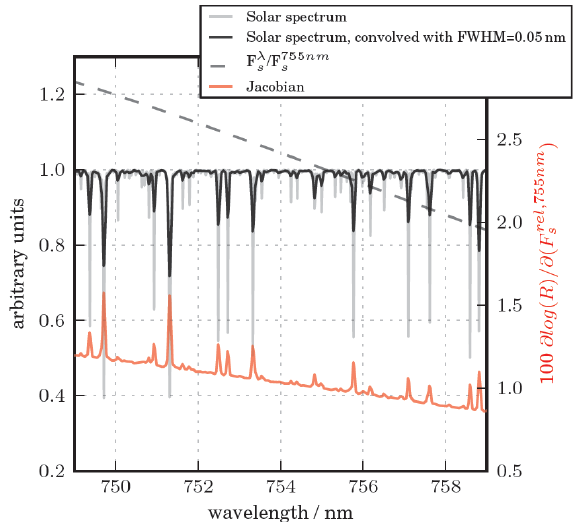
Fig. 14. Potential for fluorescence retrievals in the 749–759nm range with an imaginary instrument (spectral resolution of 0.05nm FWHM – FWHM=Full Width at Half Maximum). The gray and black solid lines show the solar transmission spectrum at natural and 0.05nm FWHM spectral resolution, respectively. The dashed line depicts the spectral shape of a typical fluorescence spectrum (nor- malized to 755nm). The red line (right axis) shows the derivative of the logarithm of the measured radiance with respect to a change in F s (defined as change in percent of continuum level radiance at 755nm, equivalent to F rel s in Frankenberg et al., 2011a).